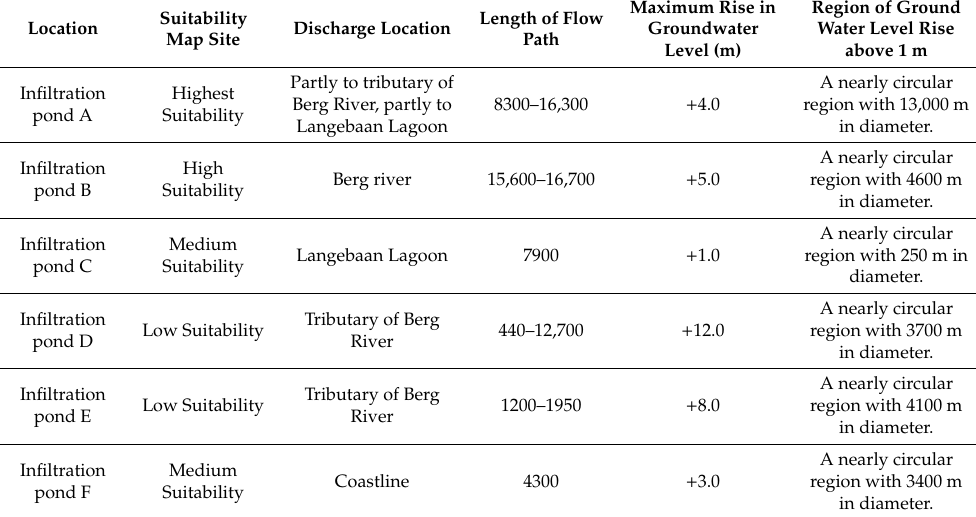
Figure 12. Rise in groundwater level and the flow paths of the recharged water. The unit of rise in groundwater contours is meters (m), and the interval of contours is 1 m. The color of the flow paths indicate the flow time: The greener the flow path, the shorter the flow time; and the more purple the flow path, the longer the flow time. Table 4. Simulated results of implementing MAR in the UAU.